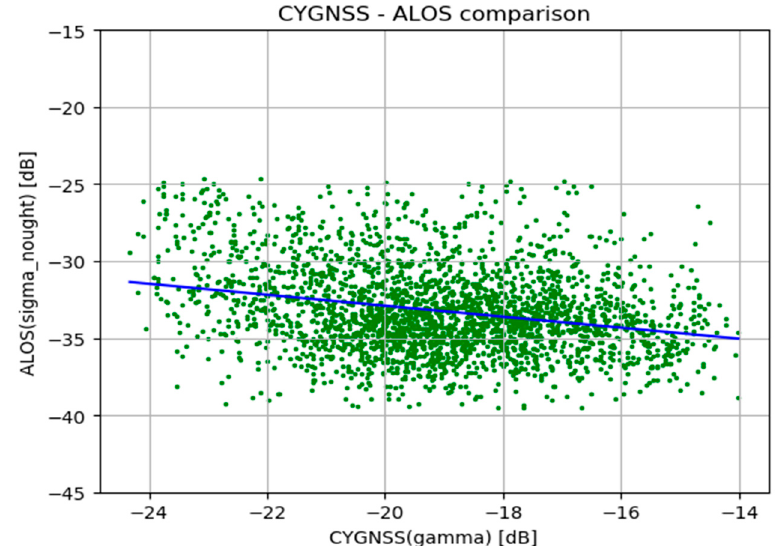
Figure 6. Plot of Advanced Land Observing Satellite-2 (ALOS-2) backscattering coefficient vs. CYGNSS reflectivity data collected over the Kufrah site, where each point corresponds to a pixel with a spatial resolution of 0.03° ×